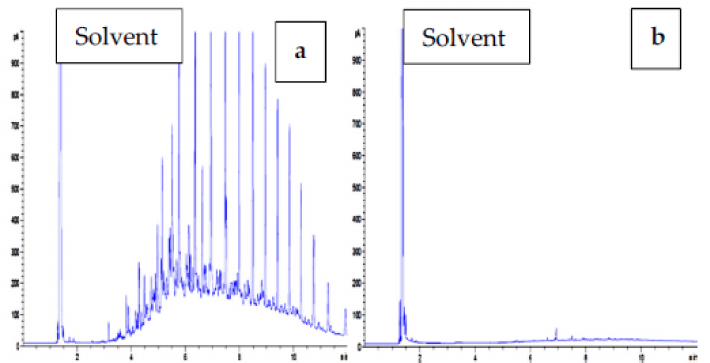
Figure 7. Comparative chromatograph of ( a ) contaminated non-rhizosphere (CN) and ( b ) contami- nated rhizosphere (1% oily sludge with C. cajan ) after 90 days.